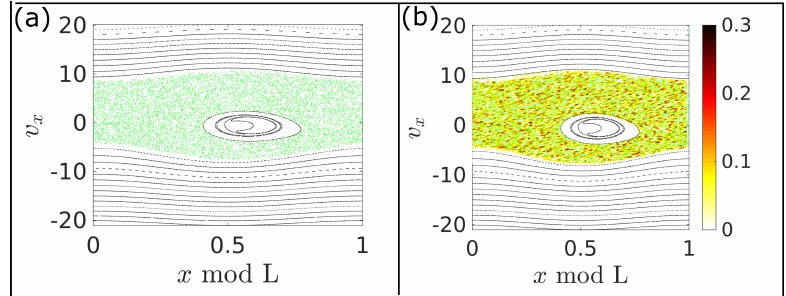
Figure 2. ( a ) The stroboscopic 2D Poincaré surface of sections (PSOS) in the ( x , v x ) plane corresponding to the driven background lattice V B . The regular islands and invariant curves (in black) denote trapped oscillations and ballistic motion respectively. The chaotic sea (in green) denotes diffusive motion. ( b ) The asymptotic particle distribution as a function of position x mod L and v x (in colormap) of all the N = 10 4 particles propagating in the setup I superimposed on the PSOS shown in Figure 2a. The parameters are the same as in Figure